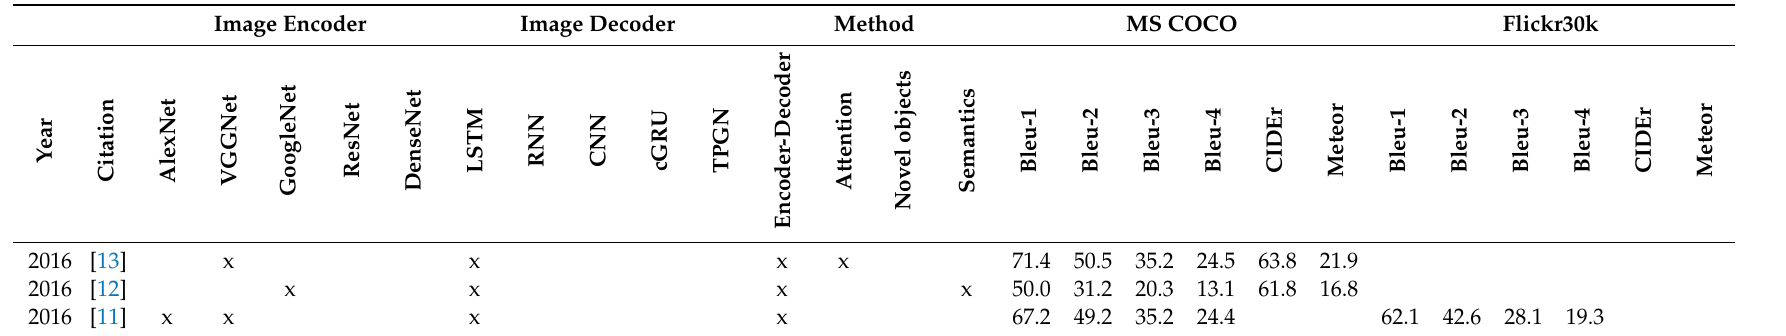
Table 5. Top 3 results in 2016 (sorted by CIDEr result on MSCOCO).